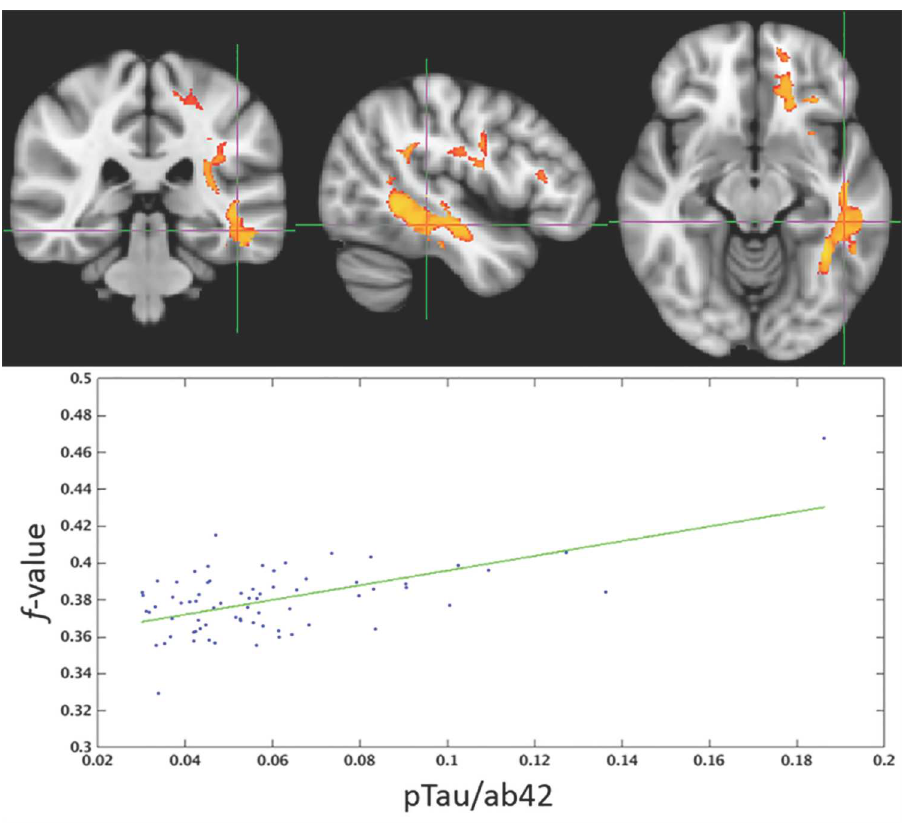
Fig 5. The largest contiguous cluster for which FWE-DTI f -value correlated with pTau 181 /A β 42. All other clusters were masked out of the image. The color scale is the same as that of Fig 3.